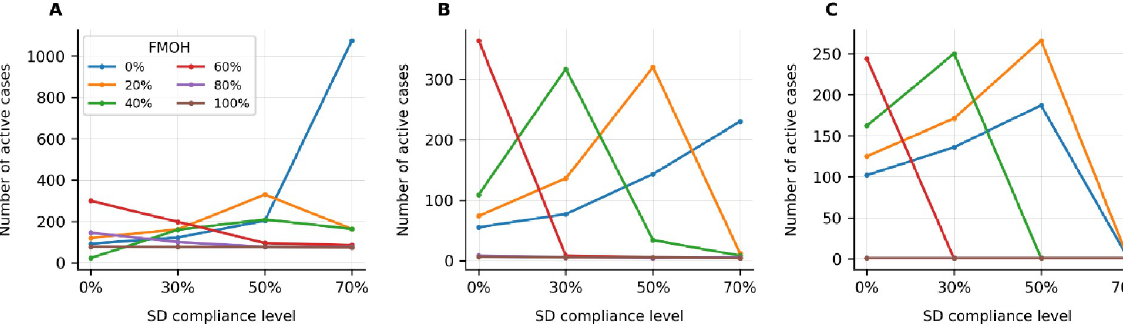
Fig 4. A comparison of the number of active cases across the different levels of FMOH and their interactions with SD levels when the TL is the same as pre-COVID for (A) ACI-L, (B) ACI-M, and (C) ACI-H. Note: the FMH is 0%.